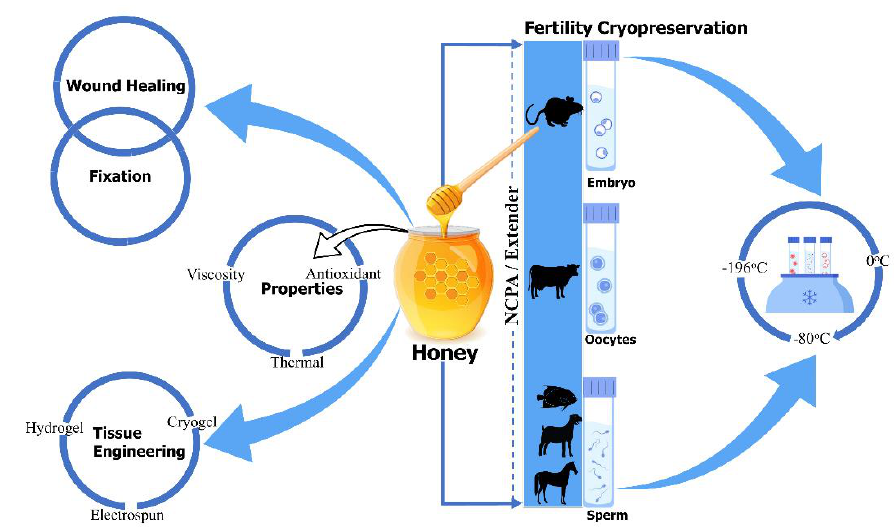
Figure 1. Honey’straditionalandmodernapplicationinmedicine, tissueregeneration, Figure 1. Honey ’s traditional and modern application in medicine, tissue regeneration, and cryo- preservation.